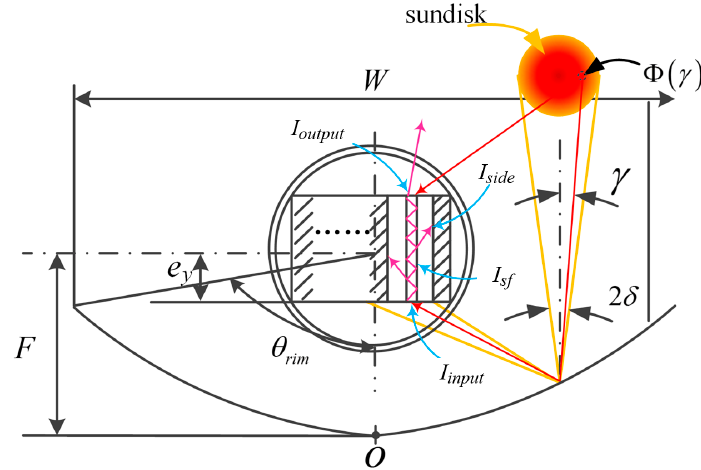
Figure 3. Diagram of transmission process of rays.